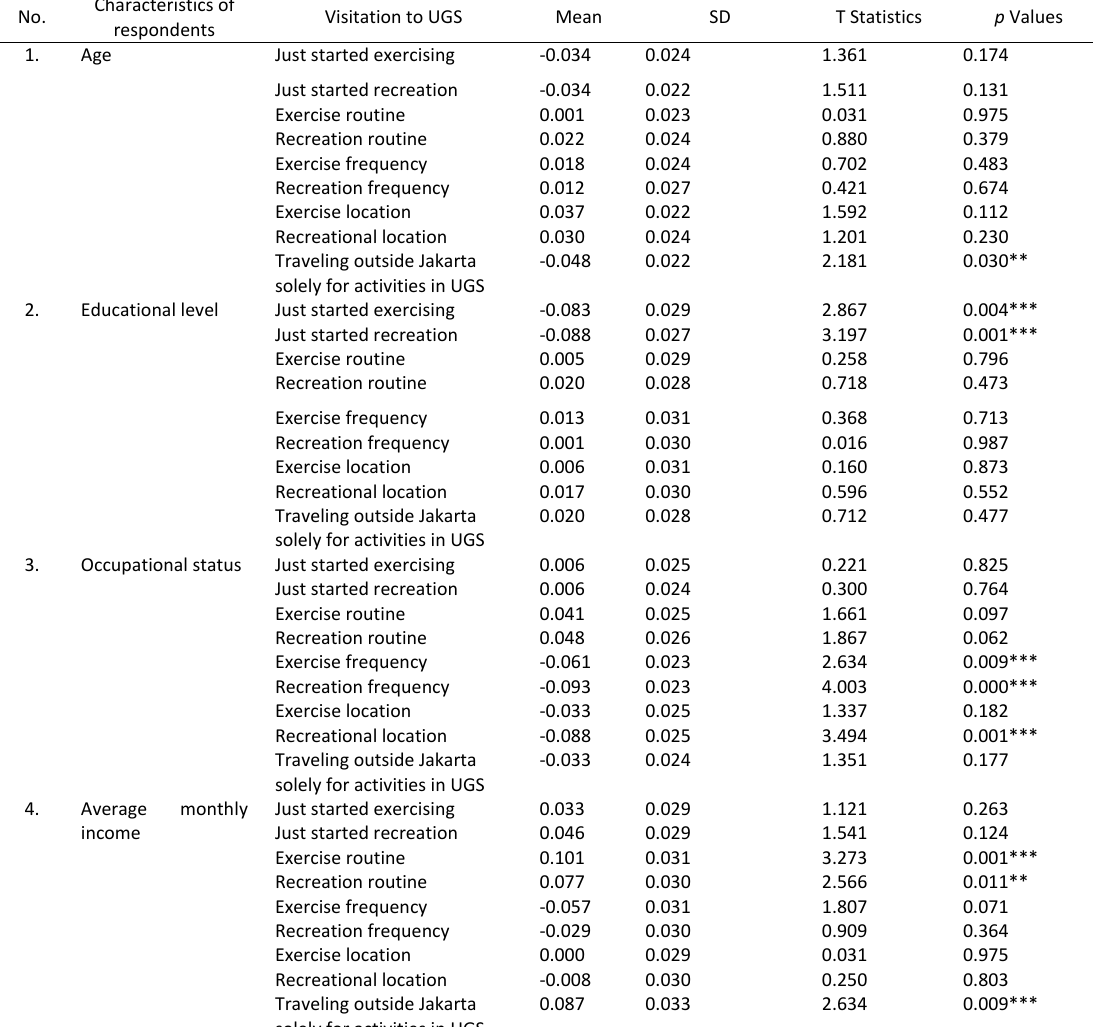
Table 5: The relationship between characteristics of respondents and visitation to UGS using PLS‐SEM